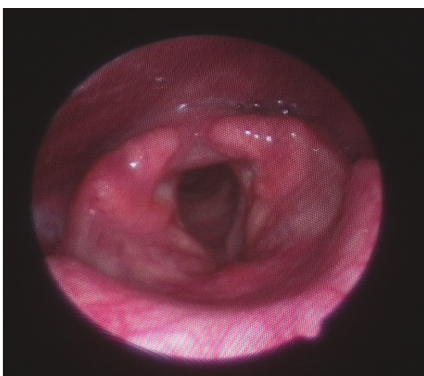
Figure 1: Nasopharyngeal fiberoptic endoscopic view of the larynx showing edema and deformity of both arytenoid cartilages during deep inspiration in a 37-year-old man with advanced rheumatoid